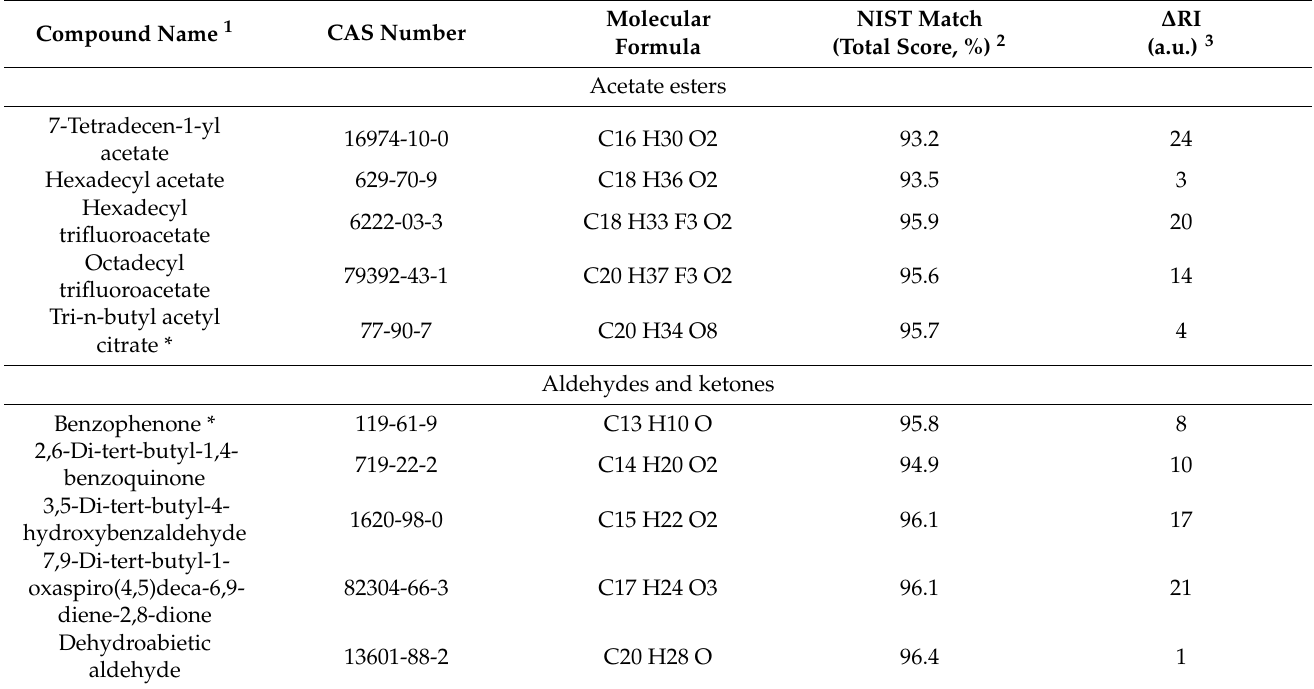
Table 2. Tentatively identified substances in the analyzed recycled LDPE